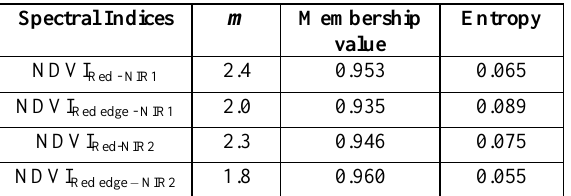
Table 2: Average membership and entropy values of wheat crop for the optimized m